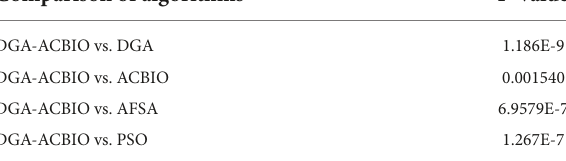
TABLE 5 Significance of differences in algorithm results.